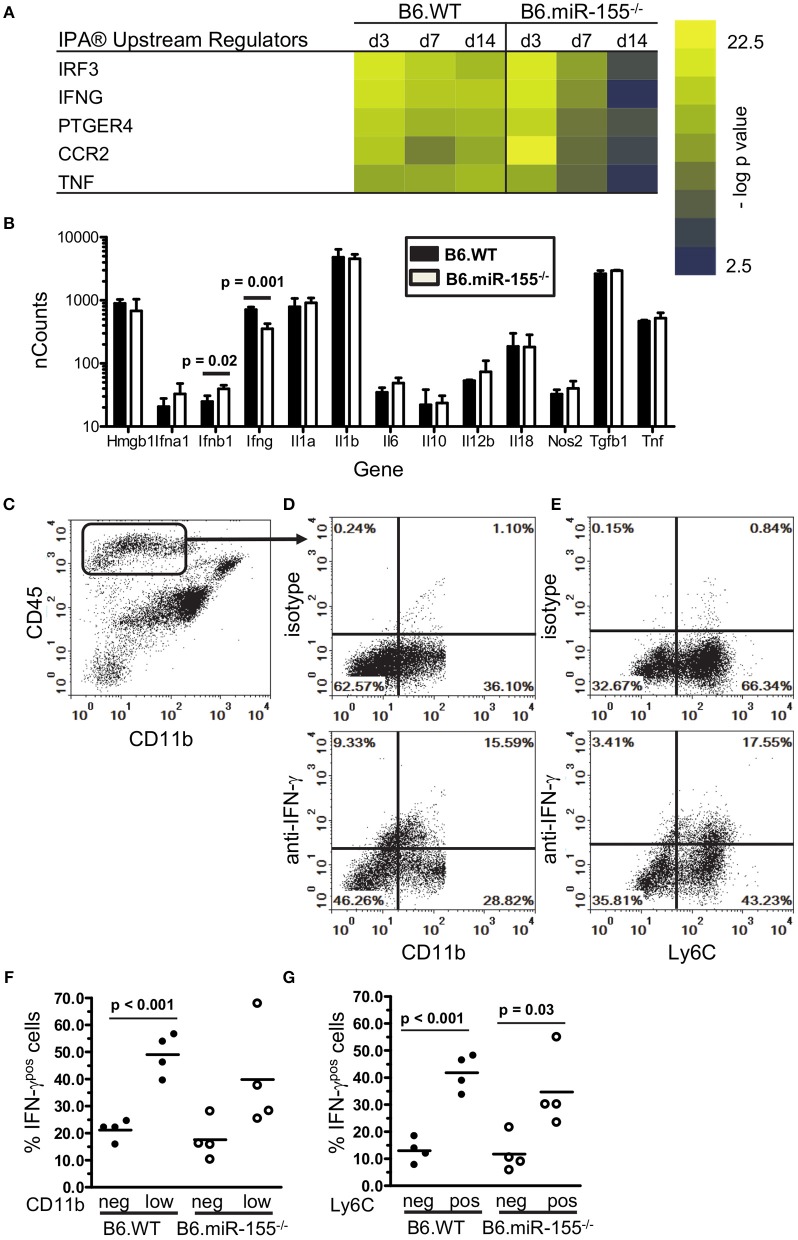
IFN-γ-producing CD45high cells are recruited to brains of infected mice. (A) Heat map shows the top 5 upstream regulators of mRNA expression identified by IPA® Pathways Analysis in microglia from infected B6.WT and B6.miR-155−/− mice. (B) CD45highCD11bpos cells from brains of B6.WT () and B6.miR-155−/− () mice 7 d p.i. described in Figure 2 were collected by FACS sorting and mRNA transcripts were quantified by nCounter. Data presented are the mean + SD nCounts of the indicated transcripts from 3 to 4 cell pools, each derived from 2 to 3 mice/genotype. Significant p-values between genotypes calculated by 2-tailed Student's t-test are given. (C–G) Brain leukocytes were harvested at 7 d p.i. from B6.WT and B6.miR-155−/− mice infected with 4.7 × 105 CFU L. monocytogenes EGD then were incubated for 4 h with PMA/ionomycin plus brefeldin A and monensin. After immunolabeling of extracellular markers, the cells were fixed and permeabilized then incubated with anti-IFN-γ or isotype control mAb and analyzed by flow cytometry. (C) Dotplot shows gating of CD45highCD11bneg/low cells from singlets. (D,E) Representative B6.WT dotplots show IFN-γ isotype (upper panels) and anti-IFN-γ (lower panels) mAbs vs. CD11b (D) and Ly6C (E) on gated CD45highCD11bneg/low cells. Graphs (F,G) show percentages of IFN-γpos cells from B6.WT () and B6.miR-155−/− () mice from 2 separate experiments that are grouped according to expression of CD11b (F) and Ly6C (G). Line represents the group mean. Significant p-values calculated by 2-tailed Student's t-test are given.